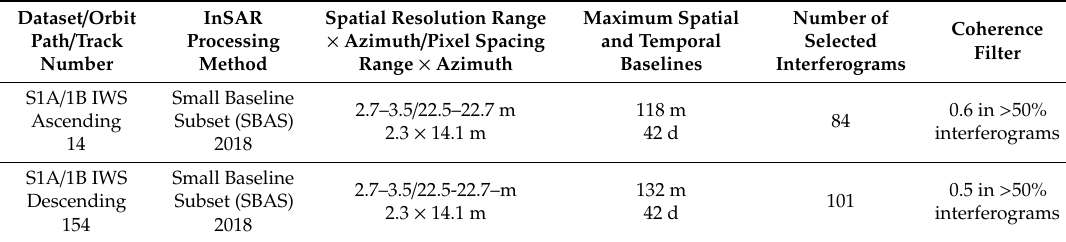
Table A1. Interferometric Synthetic Aperture Radar (InSAR) processing methods and